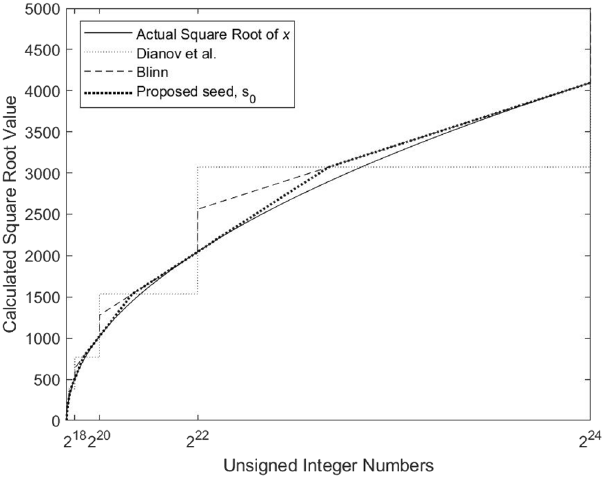
n − 1 by Dianov et al.,